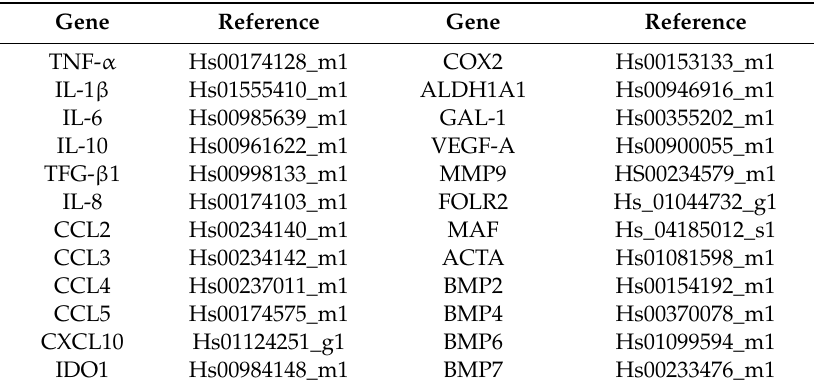
Table 1. TaqMan gene expression